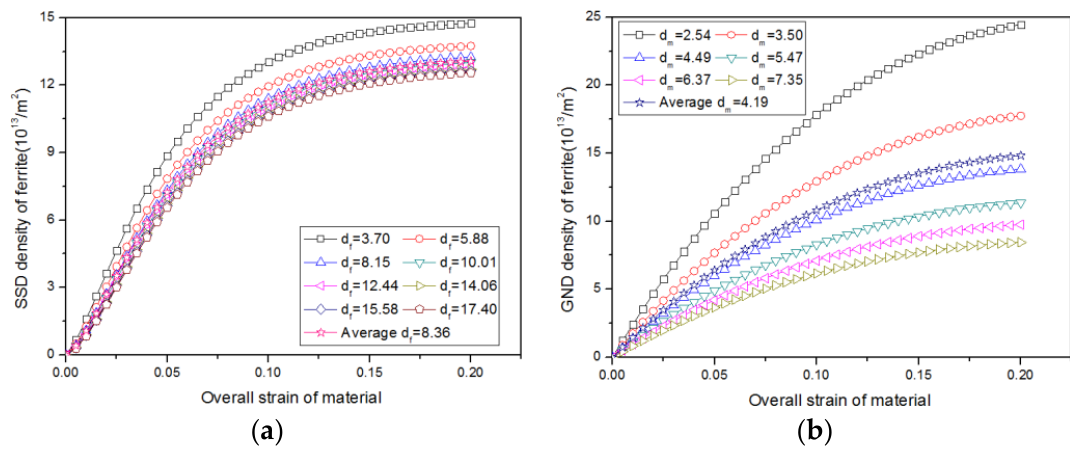
Figure 10. Dislocation density: ( a ) SSD density, ( b ) GND density.